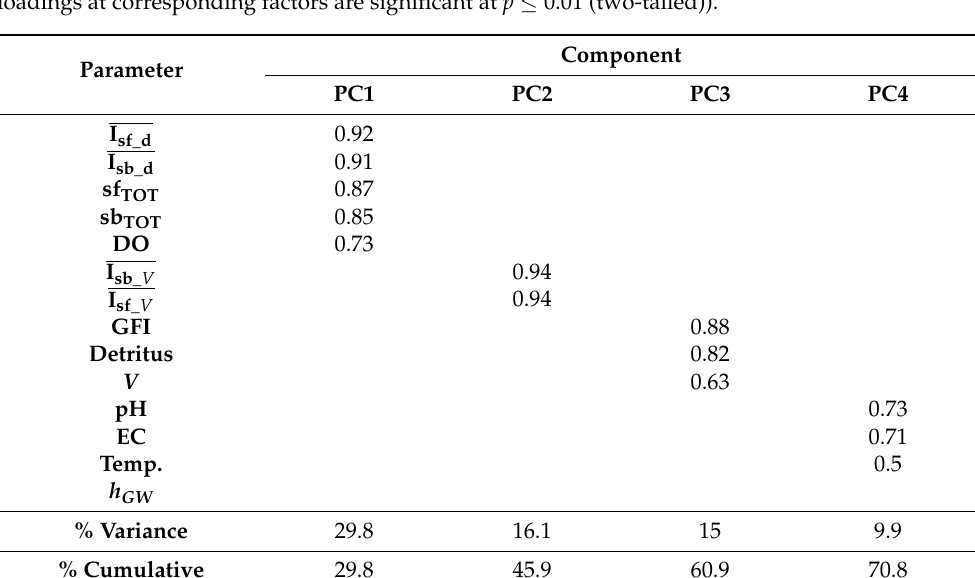
Table 6. Principal component loadings from 14 variables for 80 samples collected from November 2018 to October 2019 in five sampling campaign in Schöppinger Berg (correlation coefficients of loadings at corresponding factors are significant at p ≤ 0.01